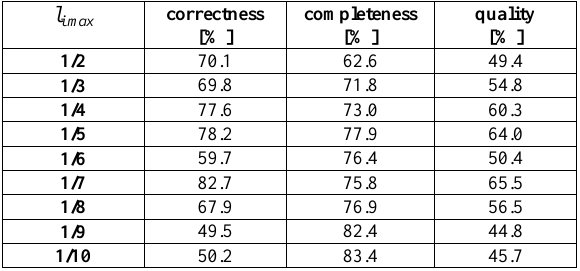
Table 2. Results for area 1 varying the maximal length ratio